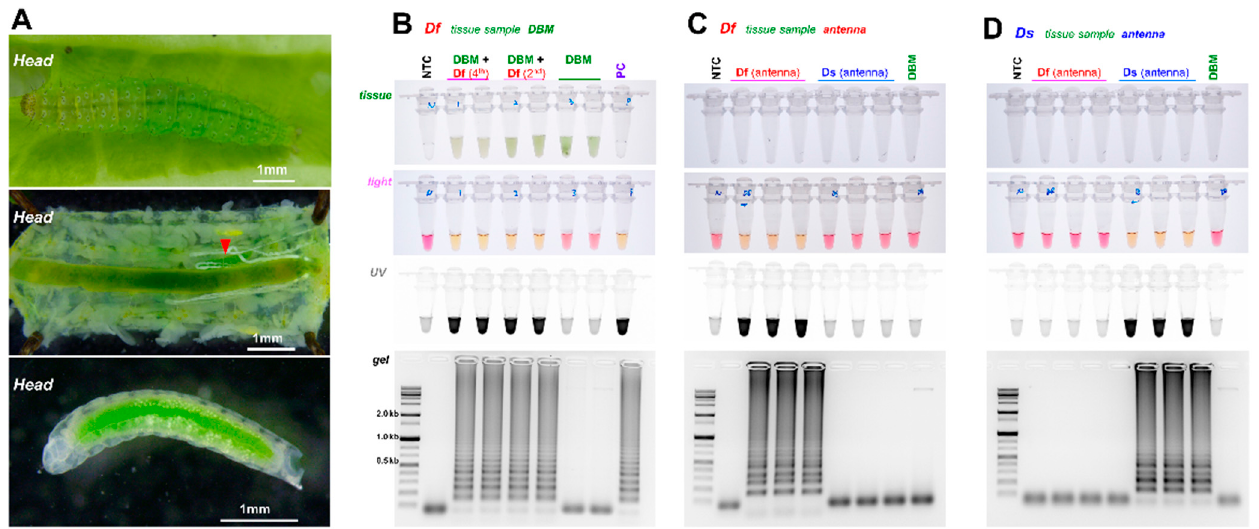
Figure 6. ( A ) Dissection of Plutella xylostella . The red triangle indicates the larvae of the parasitoid. ( B , C ) Representative results of LAMP assay with the DNA release technique from ( B ) insect tissue (parasitic and non-parasitic larvae), ( C ) antenna of Df, and ( D ) antenna of Ds. The whole larval tissue of DBM with or without Df and partial fragment of the antenna were incubated at 95 °C for 5 min and used as a template. LAMP assay results were generated with incubation at 63 °C for 35 min, with five primers (F3, B3, FIP, BIP, and LB), under visible light, ultraviolet light with SYBR Green, and gel electrophoresis. Df, Diadegma fenestrale ; Ds, Diadegma semiclausum ; DBM, diamondback moth; LAMP, loop-mediated isothermal amplification; NTC, no template control; PC, positive control.